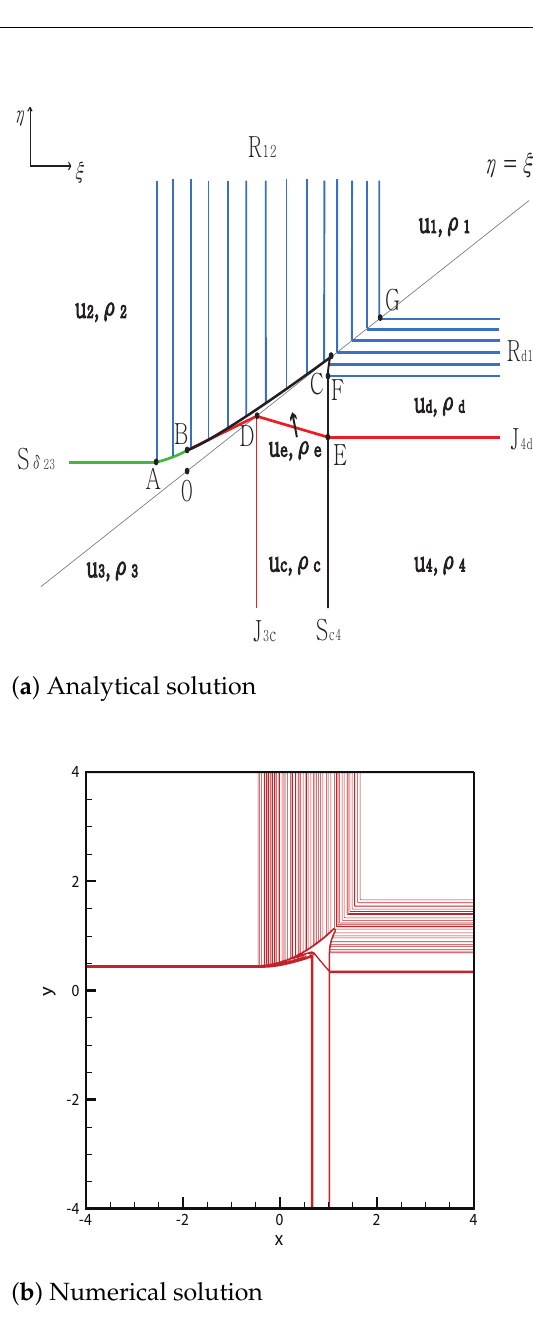
Figure 11. Case 11. R + S δ + JS + JR . Case 12. S δ + R + SJ + RJ ( u 4 < u 1 < u 3 < 0 < u 2 )